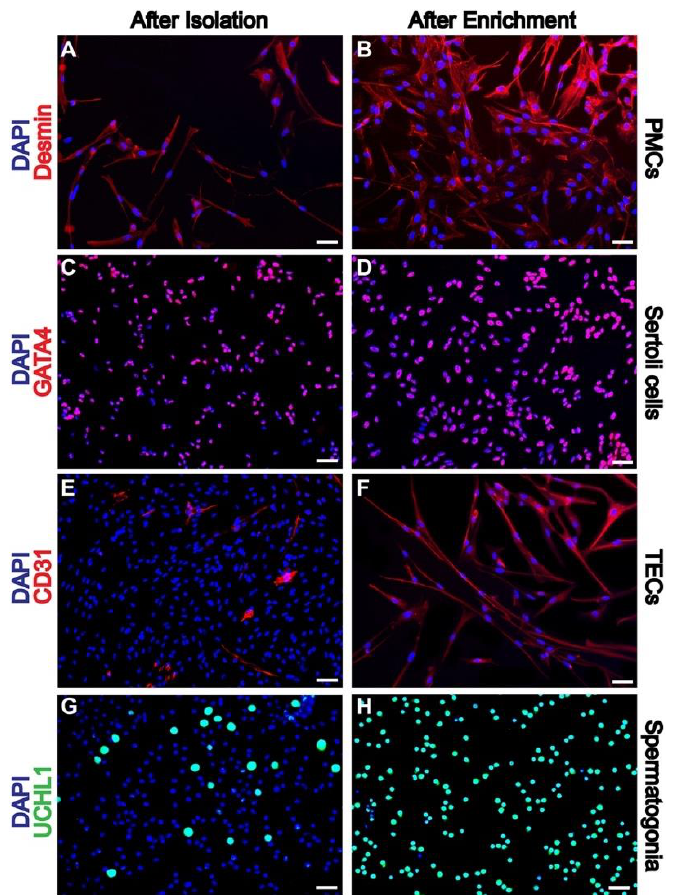
Figure 1. Purity of testicular feeder cells and spermatogonia increases after differential plating, passaging feeders, and FACS for spermatogonia. PMCs ( A , B ) (Immunofluorescence (IF) for desmin (red), DAPI (blue)), Sertoli cells ( C , D ) (IF for GATA4 (red), DAPI (blue)), TECs ( E , F ) (IF for CD31 (red), DAPI (blue)), and spermatogonia ( G , H ) (IF for UCHL1 (green), DAPI (blue)). DAPI was used as a counterstain for cell nuclei. Scale bars = 50 μ m.